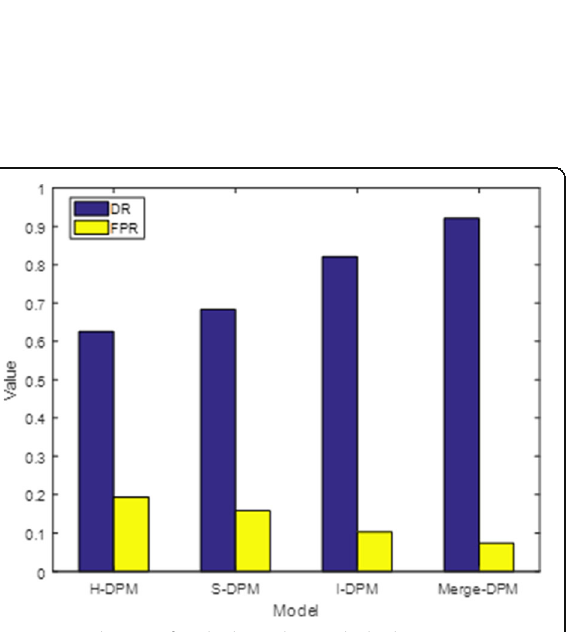
Fig. 5 Contribution of each channel. DR vehicle detection rate, FPR vehicle false positive